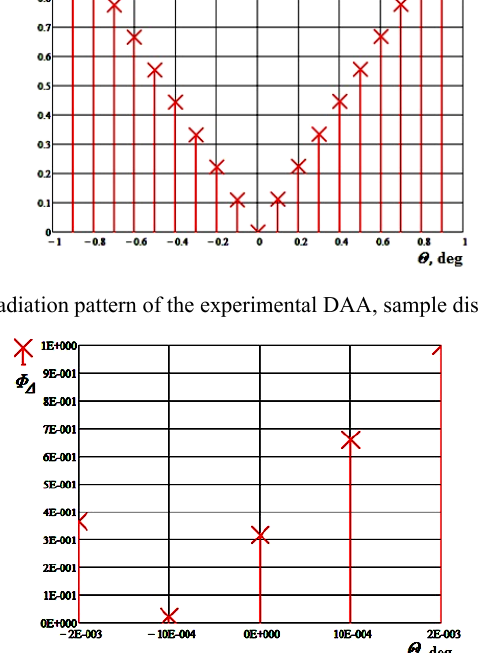
Fig. 8. The differential radiation pattern of the experimental DAA, sample discretion 0.01